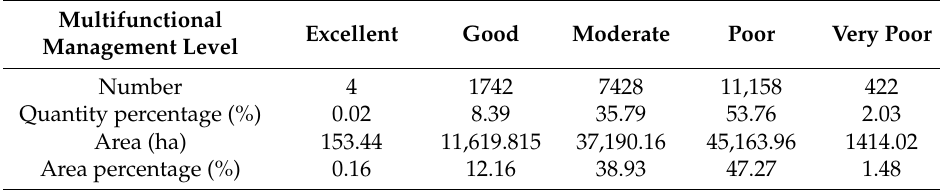
Table 7. Evaluation and statistics of multifunctional forest management level in Rongshui County of Guangxi Zhuang Autonomous Region. Excellent, Good, Moderate, Poor, and Very Poor mean multifunctional forest management level.